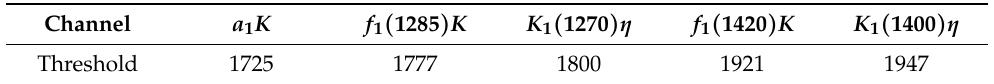
Table 3. J P = 1 − meson–meson channels with I = 1/2. The threshold masses are in the units of MeV. Here the flavor-neutral axial vector mesons have J PC = 1 ++ .